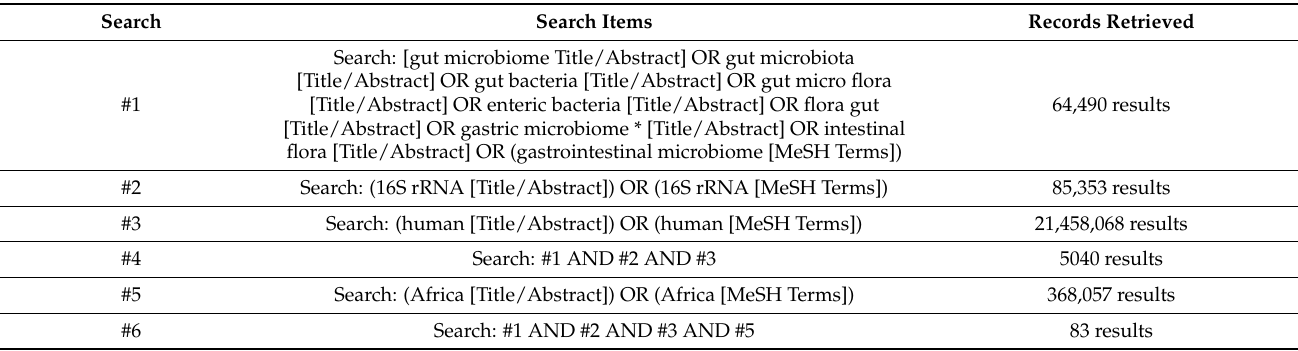
Table A1. Search strategy in PubMed (Date searched: 3 December